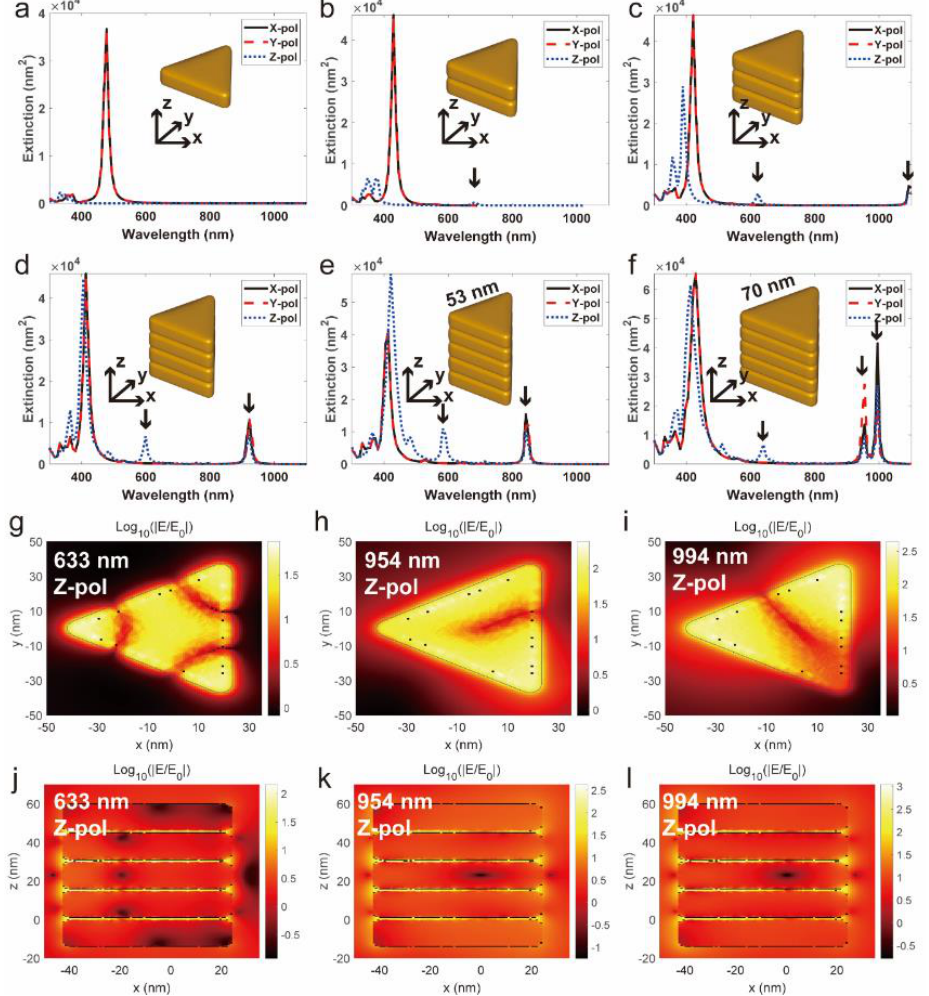
Figure 3. Theoretical simulations of the Ag nanoplates. Computed extinction spectrum for ( a ) single Ag nanoplate and ( b – e ) nano-aggregates formed with two ( b ), three ( c ), four ( d ), five ( e , f ) silver nanoplates in air under the plane-wave illumination with x-(black solid lines), y-(red dashed lines) and z-polarization (blue dotted lines). The nanoplates have a thickness of 14 nm, a gap of 1 nm and a length of 53 nm ( a – e ) or 70 nm ( f ). Computed near-field enhancement in logarithmic scale in the x-y plane ( g – i ) and x-z plane ( j – l ) through an aggregate with five Ag NPs of 70 nm length under z-polarized light illumination, with the wavelength of 633 nm ( g , j ), 954 nm, ( h , k ), and 994 nm ( e , f ), respectively. The nanoplates have a length of 70 nm and a thickness of 14 nm, and a gap of 1 nm.